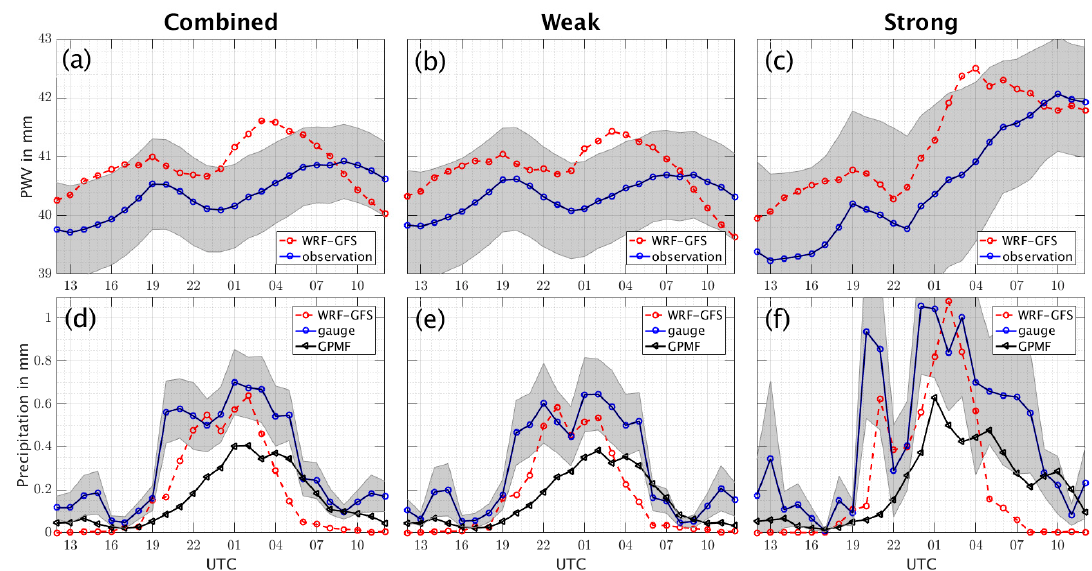
Figure 3. Mean diurnal cycle of WRF-GFS PWV and GPS-derived PWV (or observations) across 14 stations for combined strongly—weakly forced days ( a ), weakly forced days ( b ), and strongly forced days ( c ). Mean diurnal cycle of precipitation across 14 stations, based on WRF-GFS simulations, rain gauge measurement, and GPM Final product for combined strongly–weakly forced days ( d ), weakly forced days ( e ), and strongly forced days ( f ). Shaded areas in grey represent standard errors of the observations.